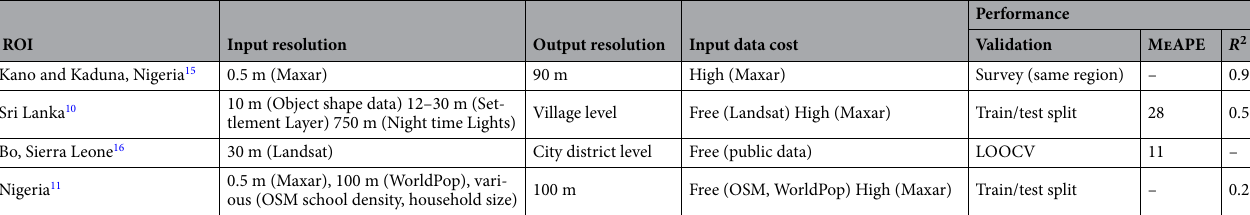
Table 1. Summary of recent literature on census-independent population estimation. Note: ROI is region of interest, LOOCV is leave one out cross validation, MeAPEis median absolute percent error.